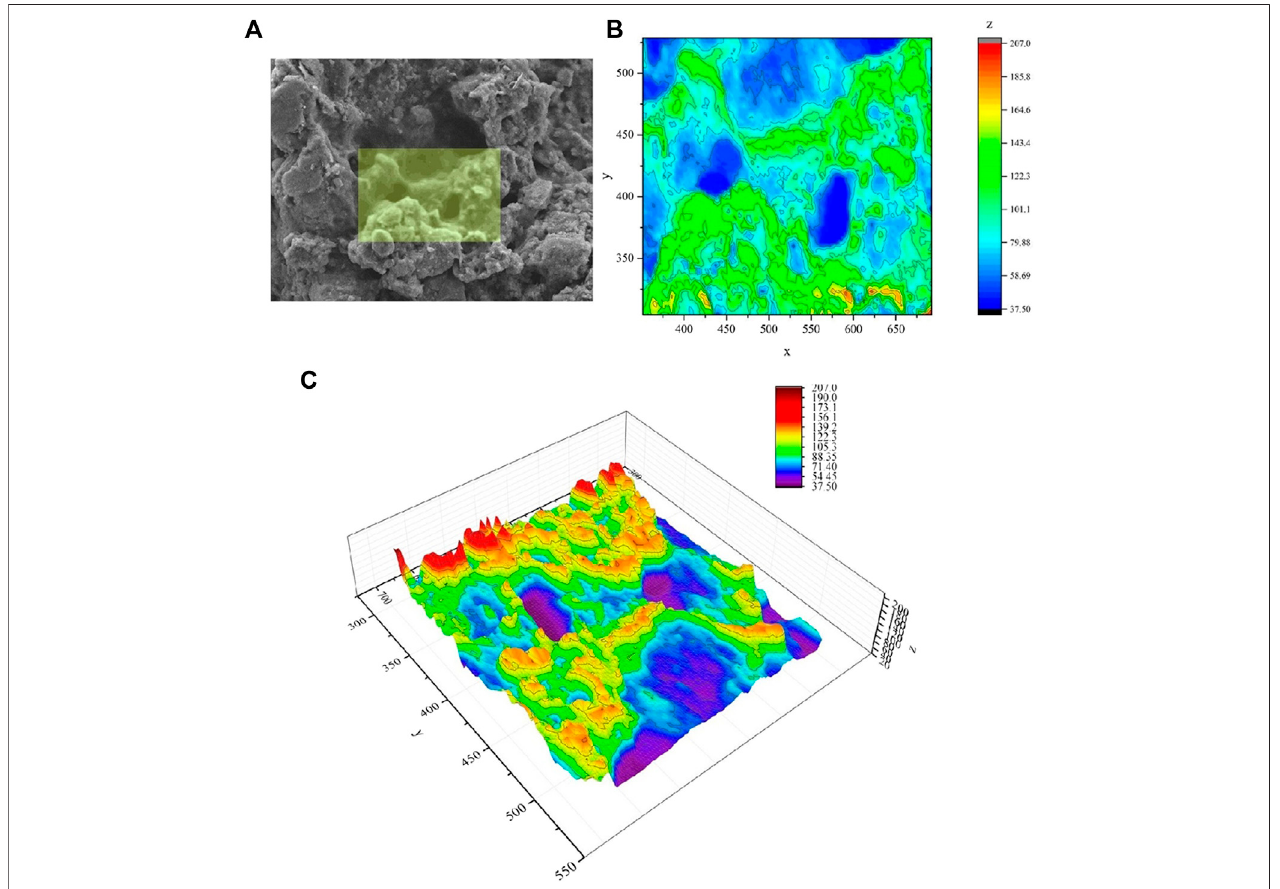
FIGURE 3 | (A) micrograph of the inner section of the crust acquired by scanning electron microscopy (SEM). In the micrograph is highlighted the area processed through Origin-pro software. (B) The 2D model obtained from Origin-pro software that allowed to measure areas and perimeters (the units of measure of the axis are in pixels); (C) The3DmodelobtainedfromOrigin-prosoftwarethatallowedtorepresentsmicrozones(peaksandvalleys)usefulforthecalculationofthevolumesandwere useful for the detection of potential microbial colonization area (the bar colors and axes units are in pixels).